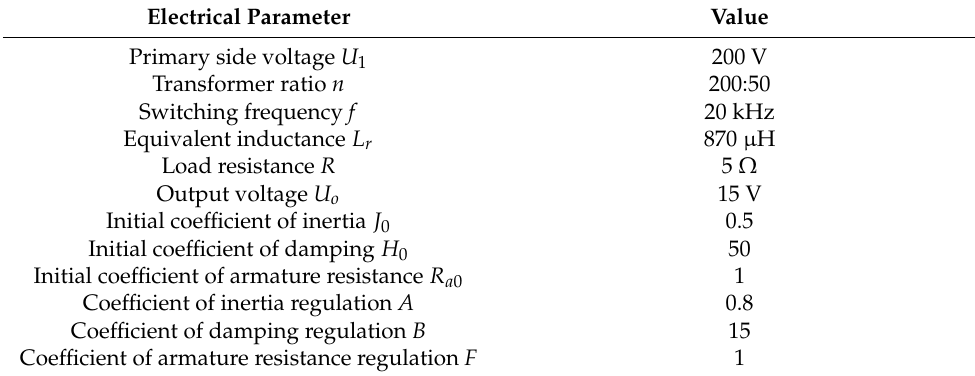
Figure 13. Converter control block diagram .